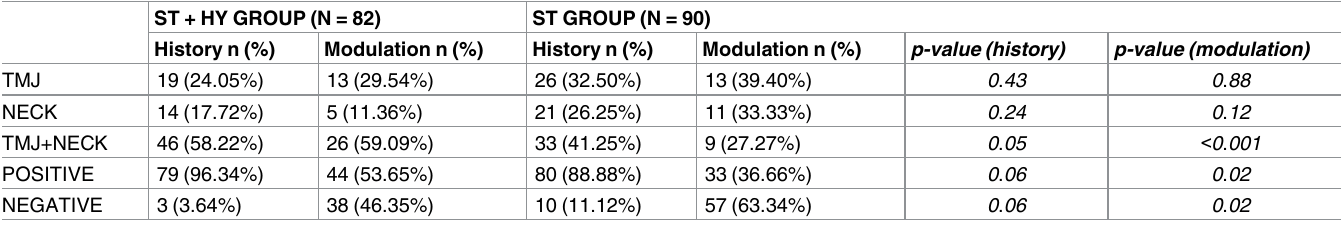
Table 4. Comparison of somatic tinnitus history and modulation between groups.